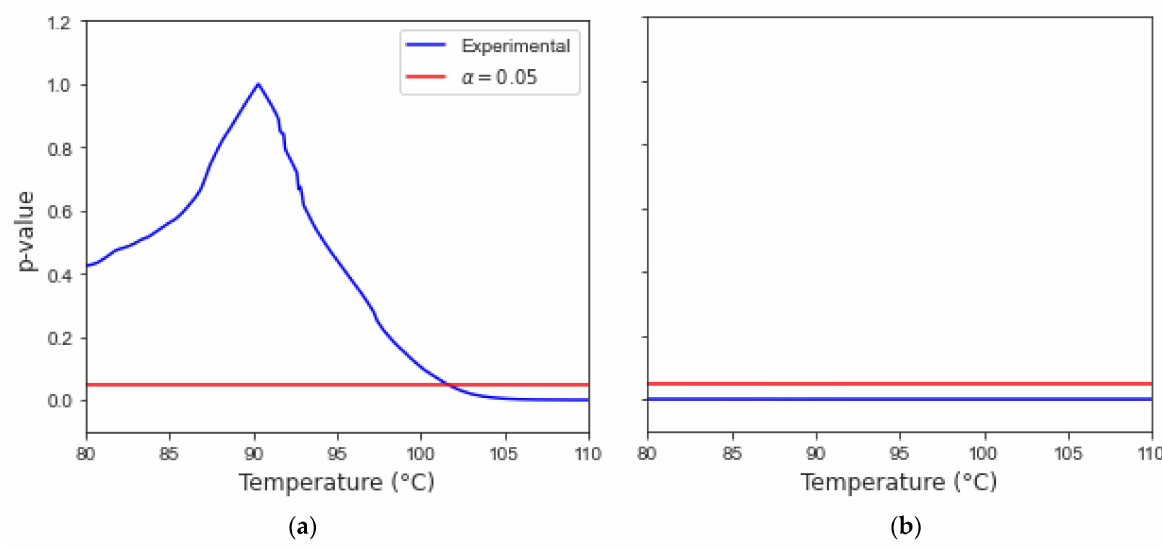
Figure 14. T-student test for Highly Diluted Water in Octane Experiments ( a ) 99.75%wt octane, ( b ) 99.9%wt octane